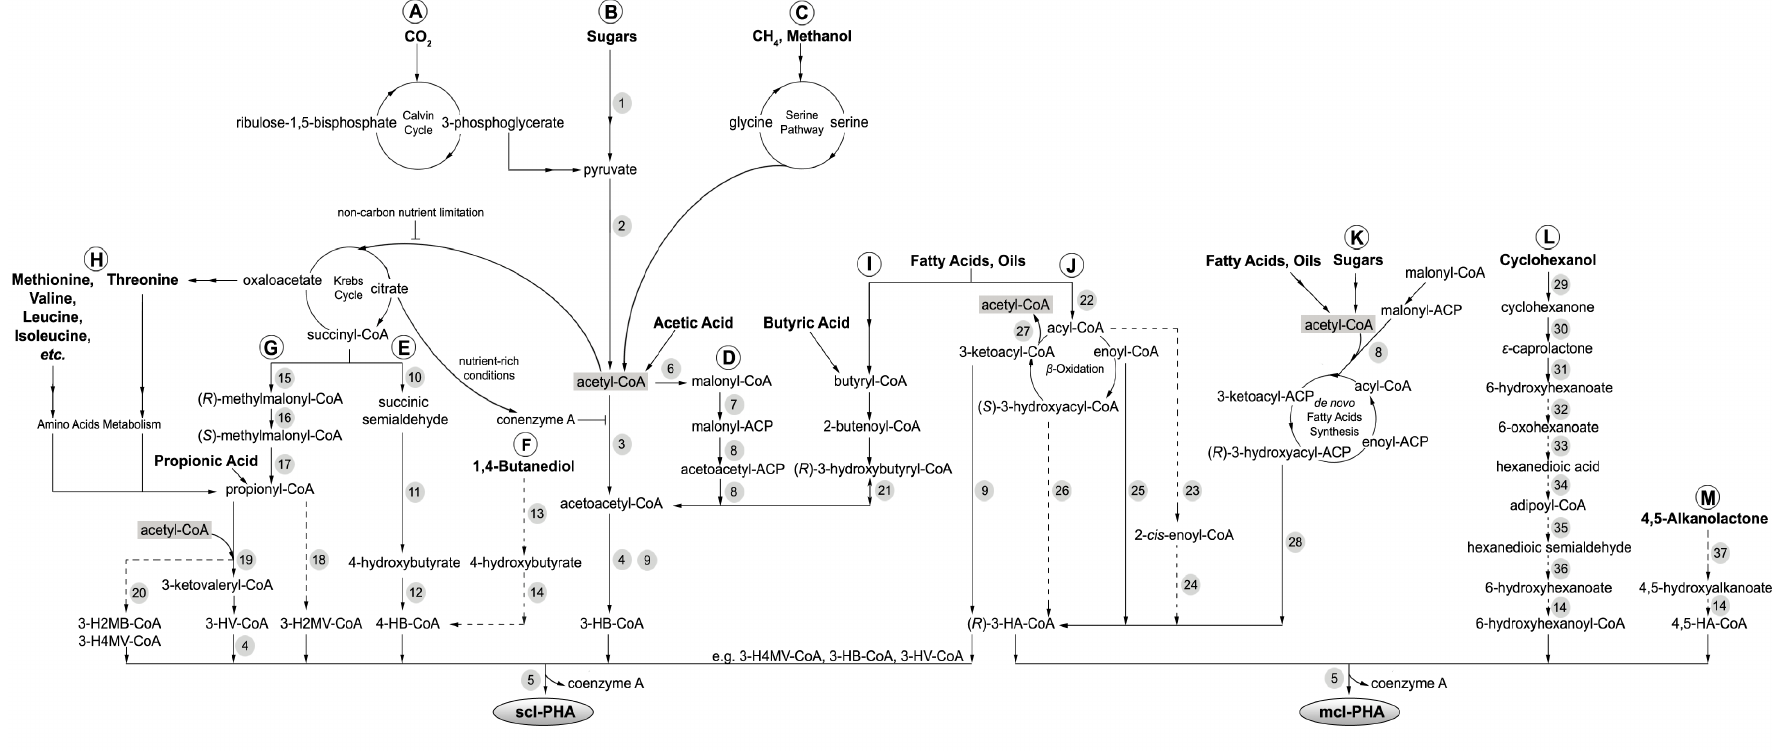
Figure 3. PHA biosynthetic pathways. Dotted lines represent putative pathways. Numbers represent enzymes involved in the chemical reactions that are summarized in Table 1. (3-H2MB-CoA, 3-hydroxy-2-methylbutyryl-CoA; 3-H4MV-CoA,